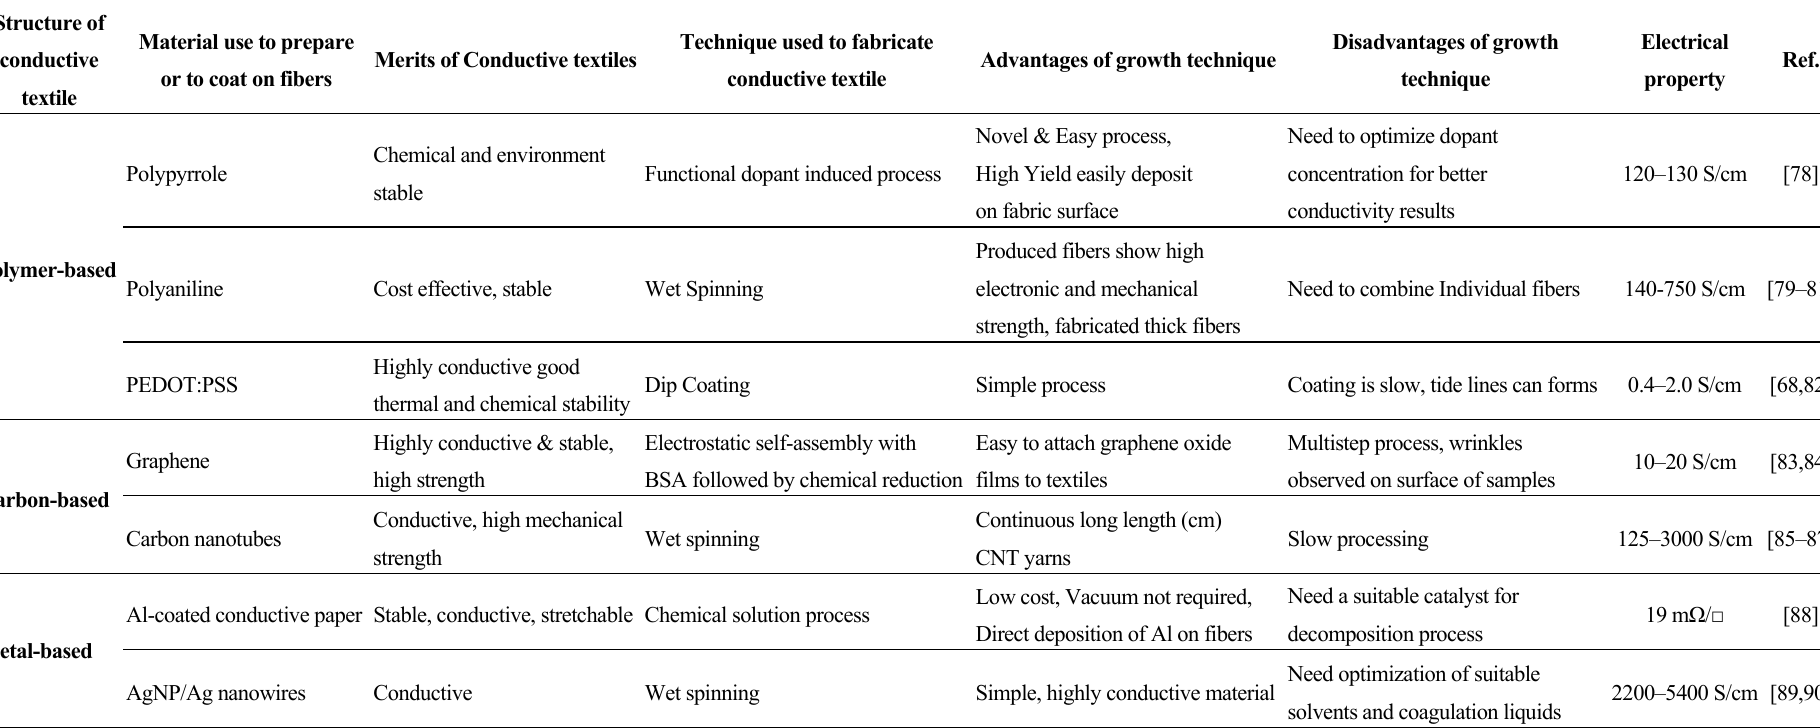
Table 1. Summary of materials and their electric